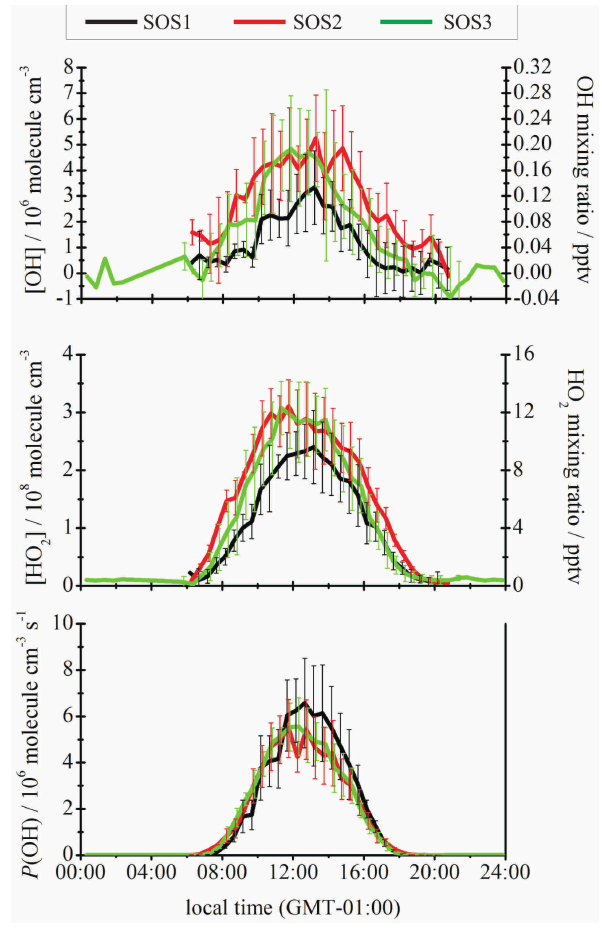
Fig. 6. Half-hourly averaged median diurnal profiles of OH (top panel), HO 2 (middle panel) and primary production rate of OH, P (OH) (bottom panel); SOS1–3 are represented by the black, red and green lines, respectively. The error bars represent the 1 σ day- to-day variability of the